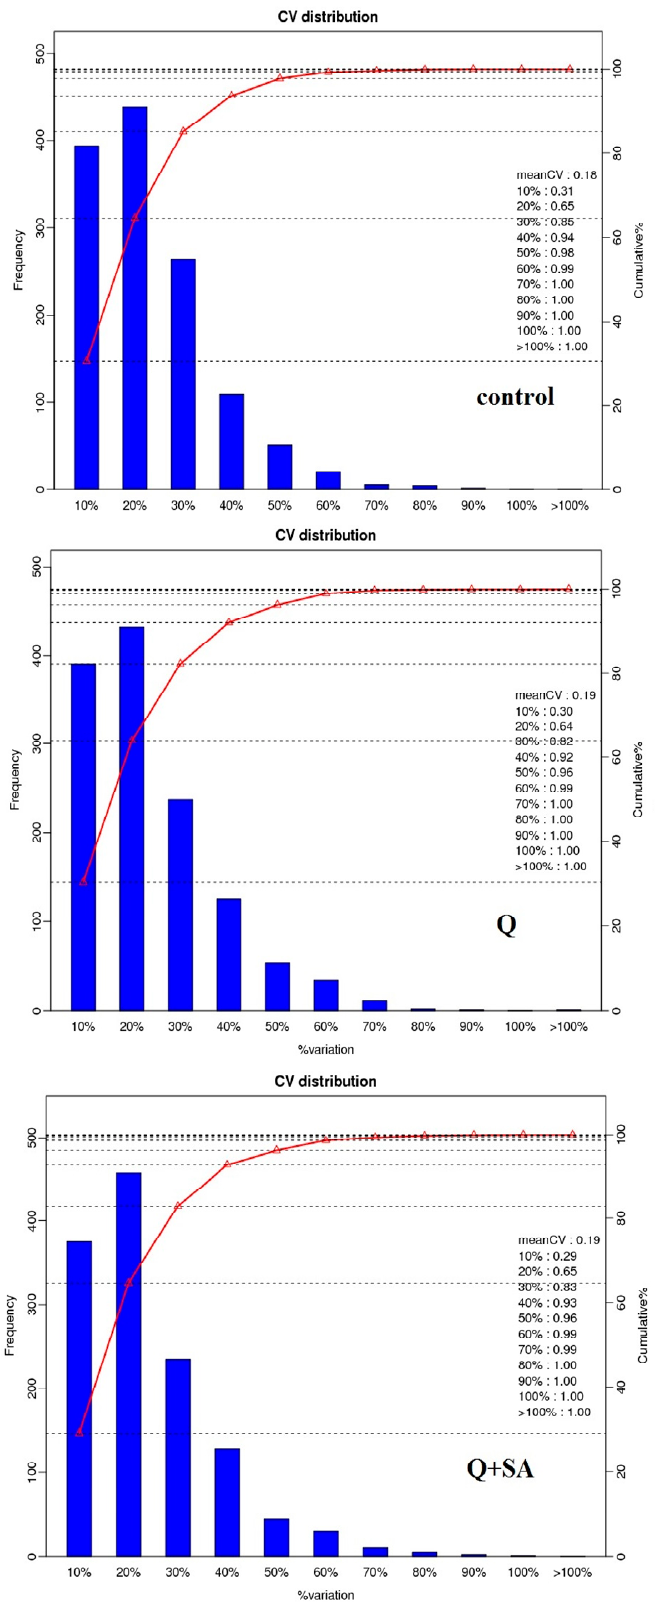
Figure 3. Three plots, one for each group (control, Q and Q + SA), that show the CV values (%) for comparing protein quantifications over the length of identified